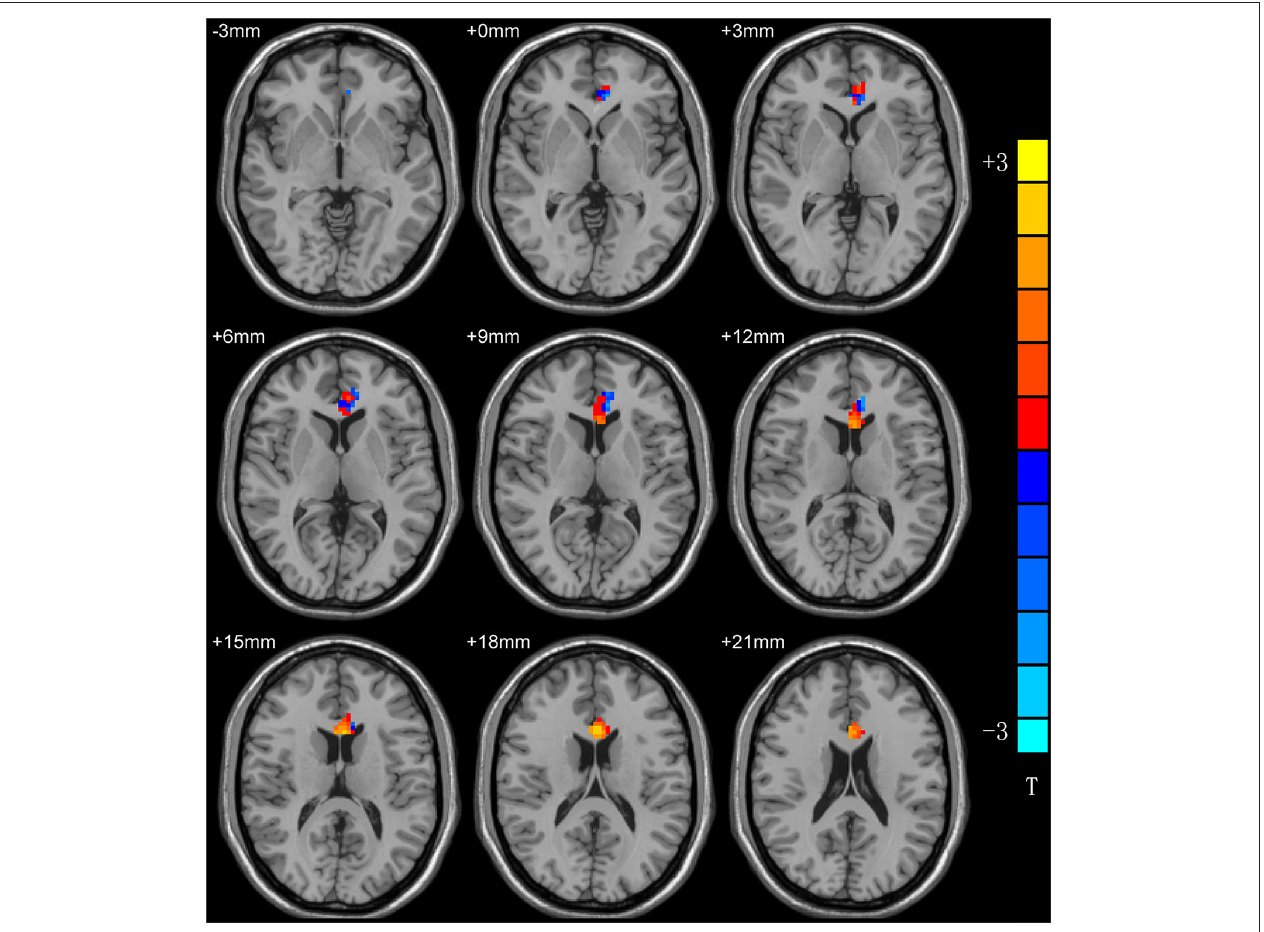
FIGURE 1 | ReHo differences between patients with MDD and HCs. Red and blue denote higher and lower ReHo, respectivsely, and the color bars represent the T -values from the two-sample t -test of the group analysis. ReHo, regional homogeneity; MDD, major depressive disorder; HCs, healthy